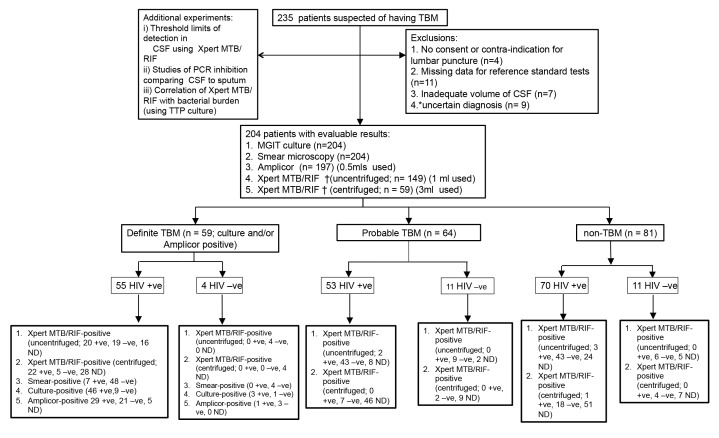
Summary flow chart of patient recruitment and diagnostic testing performed.MGIT, Bactec MGIT 960; ND, not done; +ve, positive; −ve, negative. * These patients could not be clearly categorised as definite TBM, probable TBM, or non-TBM (e.g., reference negative and lost to follow-up, and without initiation of TB treatment). † Note that the uncentrifuged and centrifuged Xpert MTB/RIF groups include 12 patients who had both processes done, i.e., paired samples.